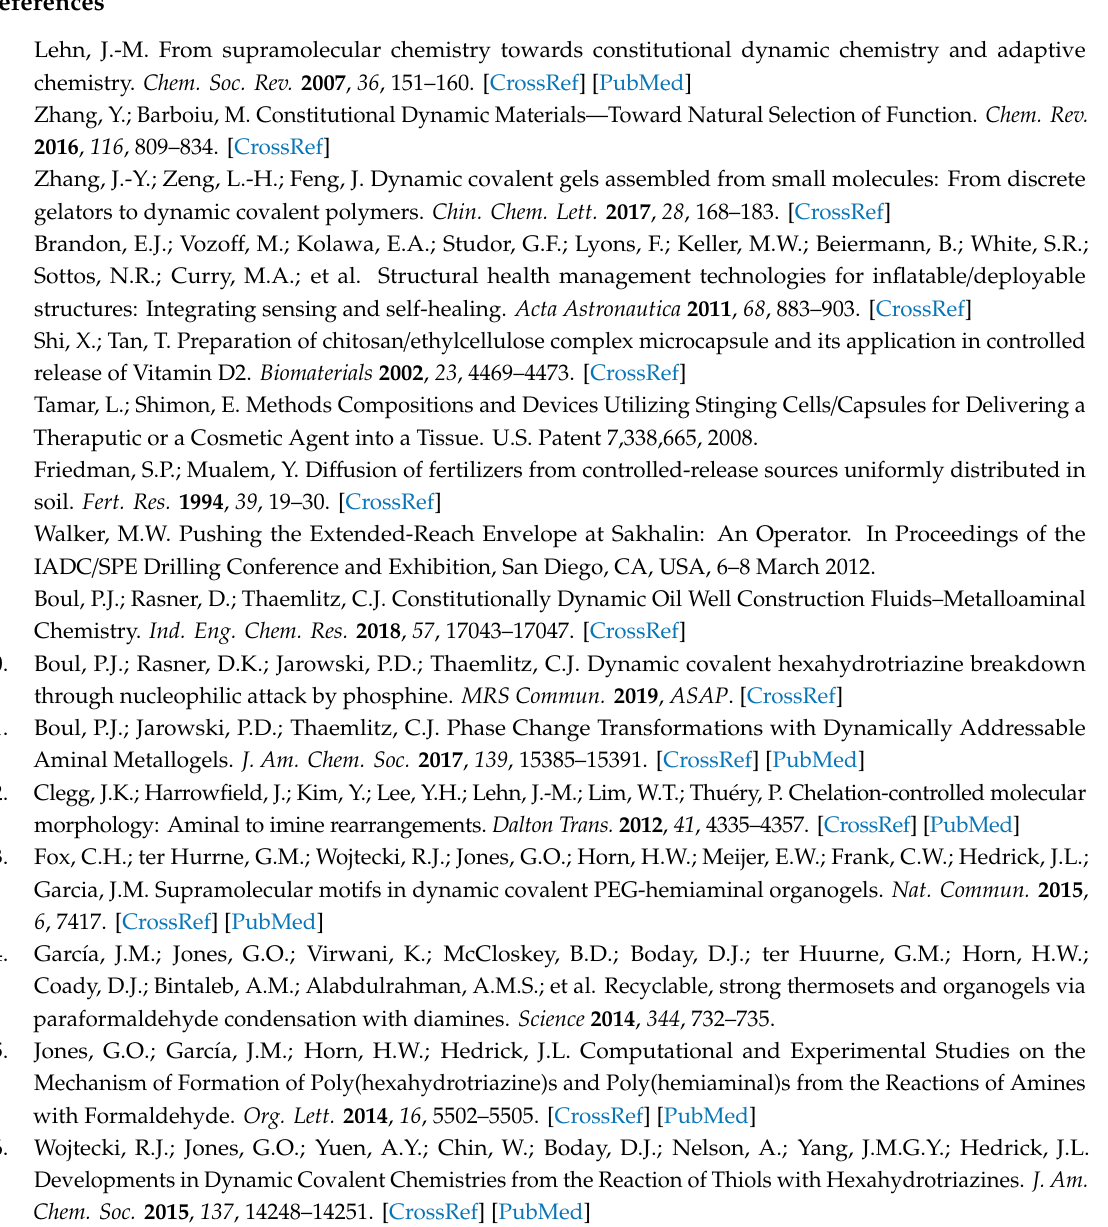
thermodynamically favoured hexahydrotriazine gel after heating the liquid in (b) (product VIII in Scheme 3); and (d) the liquid following breakdown of the gel with tris-carboxylethyl phosphine; Figure S2. PHT system without aluminum; Figure S3a. PHT system without aluminum; Figure S3b. Without aluminum at − 30 ◦ C with time resolution; Figure S4. Without aluminum at 0 ◦ C with time resolution; Figure S5. With aluminum with time resolution; Figure S6. With aluminum with time resolution; Figure S7. With aluminum with time